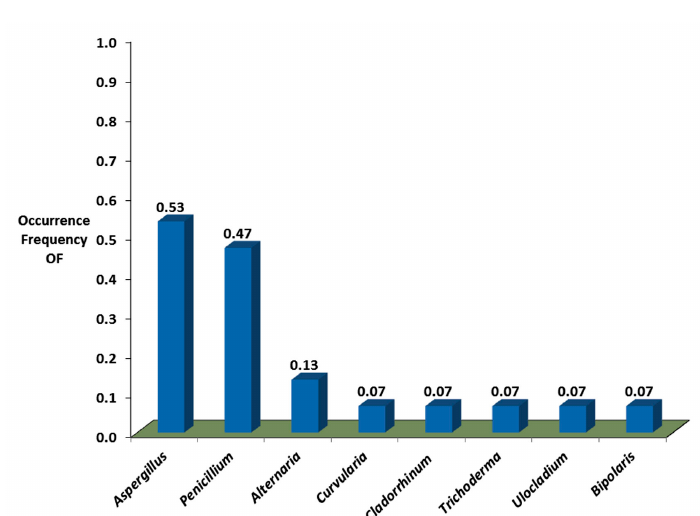
Fig. 2. Occurrence Frequency (OF) for fungi genera population isolated from hospital laboratories